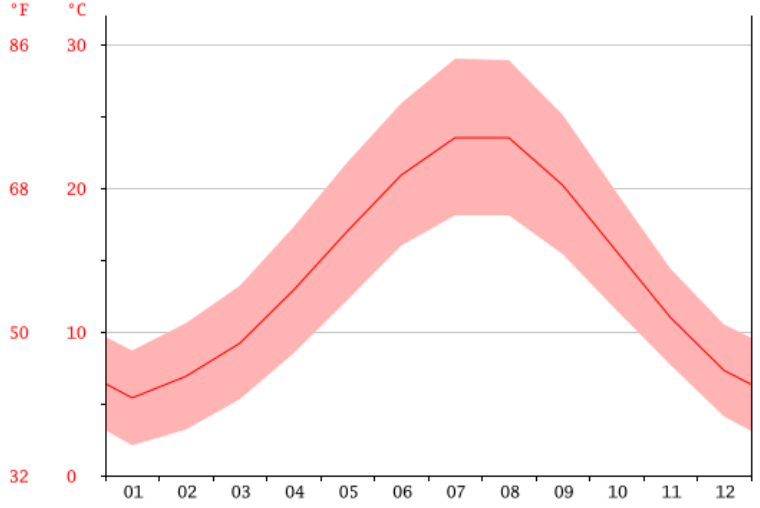
Figure 4. Ascoli Piceno average monthly temperatures.